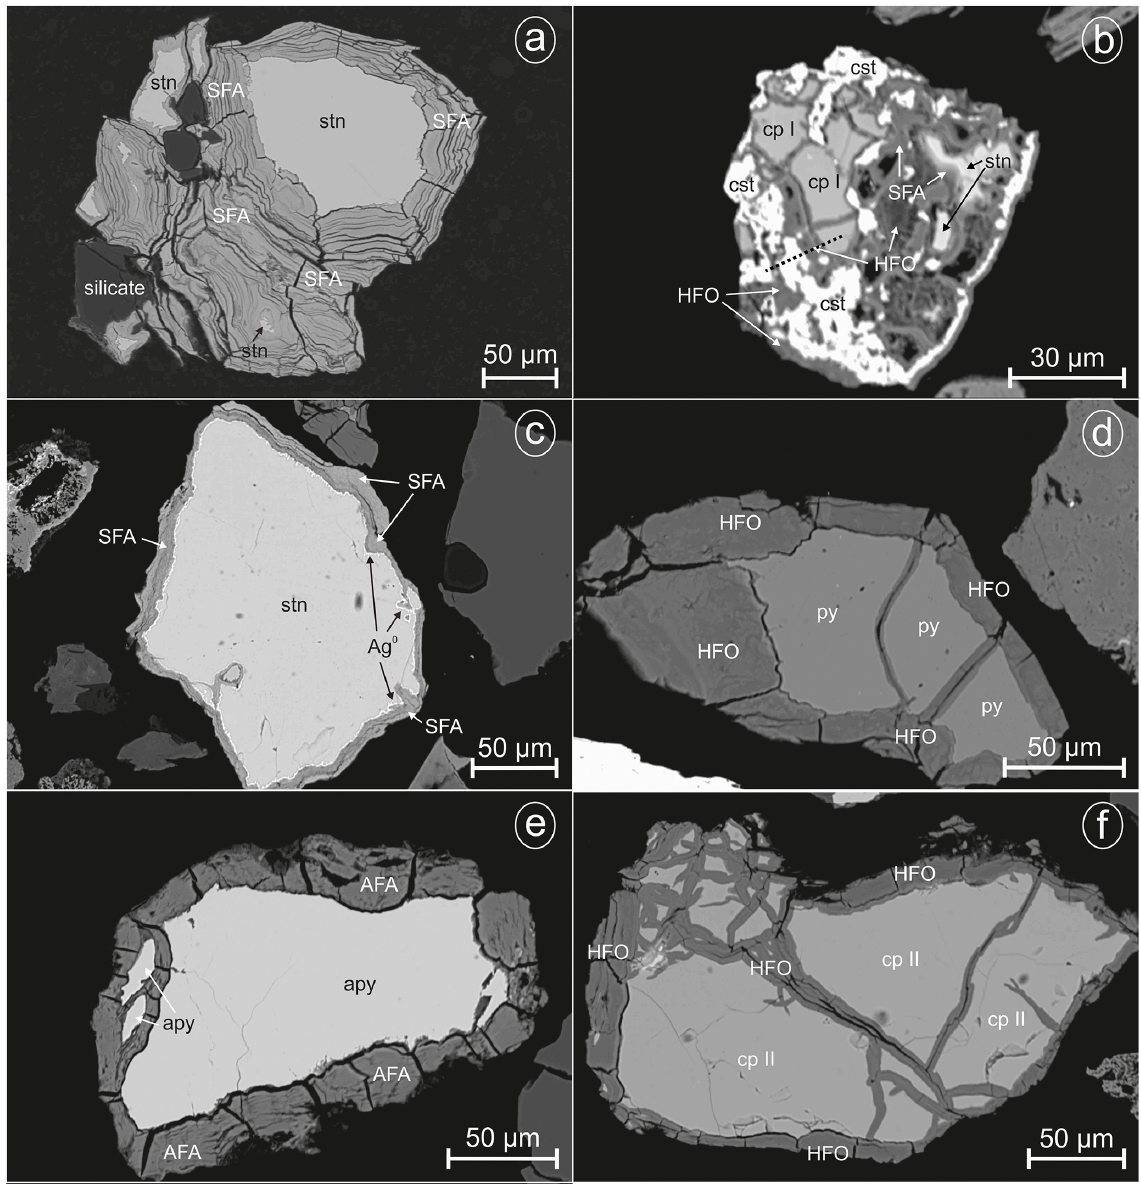
Figure 1. EMP images of investigated sulfides from Giftkies and Ka ˇ nk: (a) stannite with extensive weathering rim, (b) grain with stannite and its weathering products (dashed black line marks the TEM section in Fig. 6), (c) weathered stannite with a small cover of elemental silver, (d) relict of pyrite replaced by HFO, (e) weathered arsenopyrite replaced by AFA, and (f) chalcopyrite remnant with replacements of HFO; (AFA, amorphous ferric arsenate; Ag 0 , native silver; apy, arsenopyrite; cp I, Sn-rich chalcopyrite (chalcopyrite I); cp II, chalcopyrite II; cst, cassiterite; HFO, hydrous ferric oxide; py, pyrite; SFA, amorphous Sn–Fe–As phase; stn,